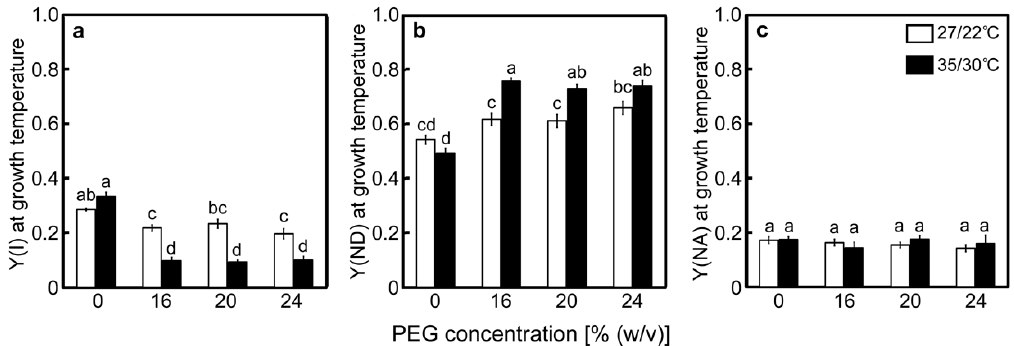
Figure 5. Redox state of P700 after drought stress treatment under two di ff erent temperature conditions in rice. Approximately 60 days after germination, hydroponically grown plants were drought-stressed using culture solutions containing PEG at 0, 16, 20, 24% ( w / v ) for two days under an irradiance of 450 µ mol photon m − 2 s − 1 and day / night air temperatures of 27 / 22 ◦ C or 35 / 30 ◦ C. P700 absorption was measured simultaneously with chlorophyll fluorescence. Panels ( a ), ( b ), and ( c ) show the results for Y(I), Y(ND), and Y(NA), respectively. Measurements were made under conditions of an actinic light intensity of 1250 µ mol photon m − 2 s − 1 , [CO 2 ] of 40 Pa, leaf temperature of 27 ◦ C (white bar) or 35 ◦ C (black bar), which corresponded to the daytime air temperature during stress treatment, and relative humidity of 60–70%. Data are presented as means ± SE ( n = 3 to 5). Statistical analysis was carried out by ANOVA, followed by Turkey–Kramer’s test. Columns with the same letter were not significantly di ff erent ( p < 0.05).